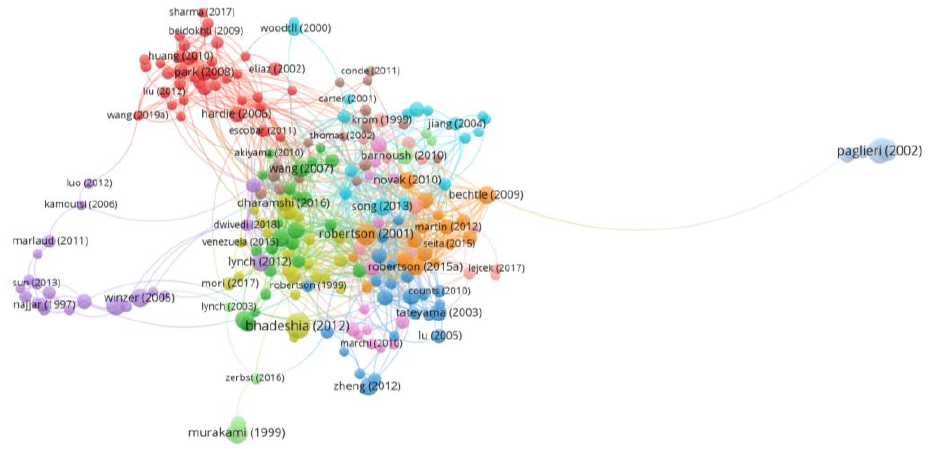
Figure 6. Citation network for publication sources for work on hydrogen embrittlement.